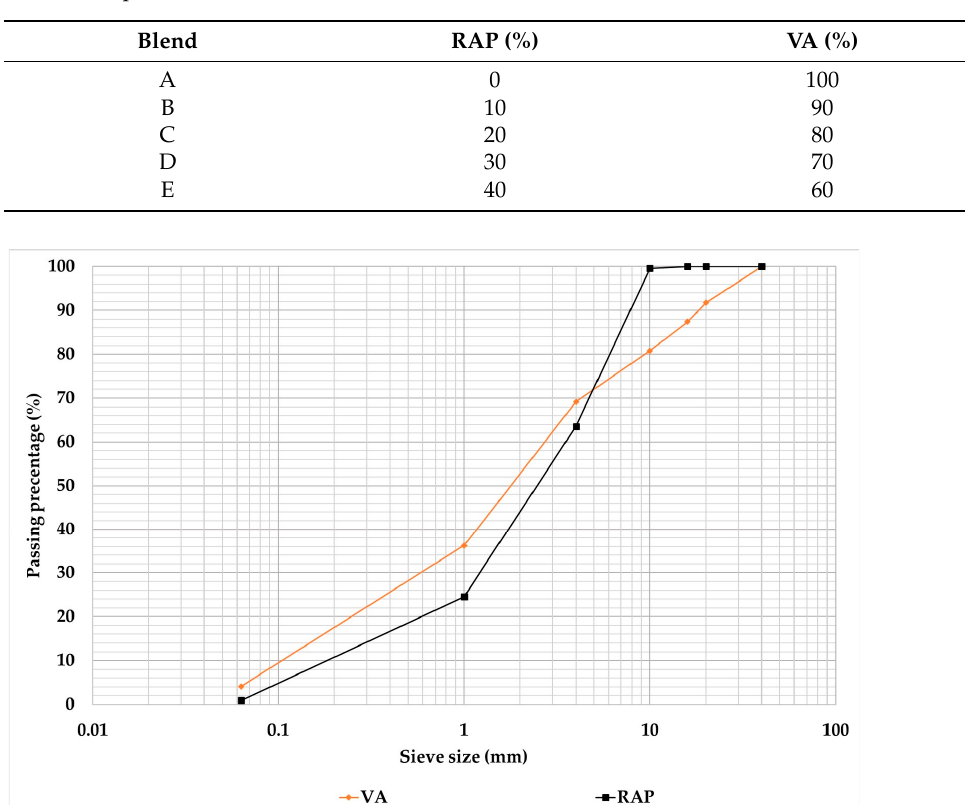
Table 1. Proportions of RAP-VA blends.